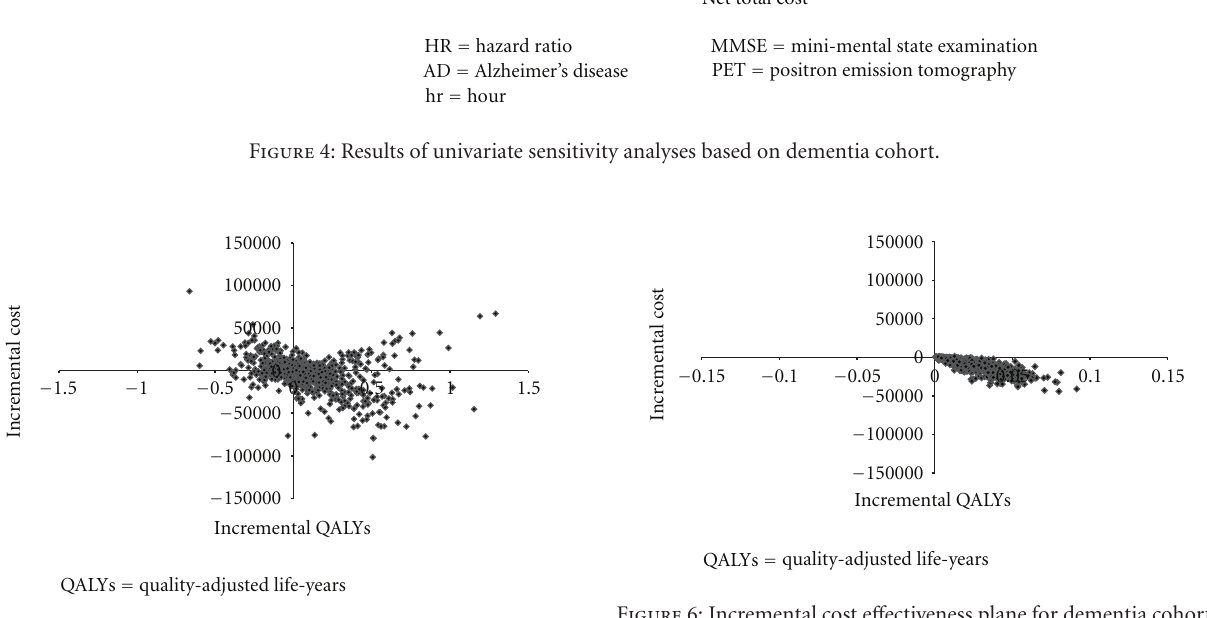
Figure 6: Incremental cost e ff ectiveness plane for dementia